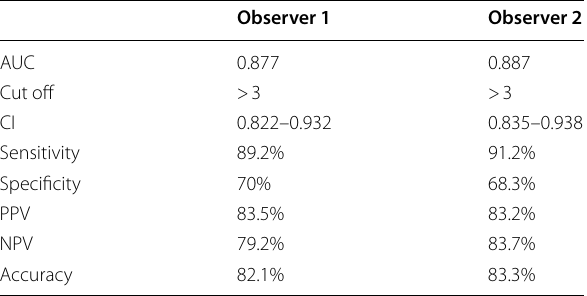
Table 4 Validity of the scoring system versus histopathology as a gold standard